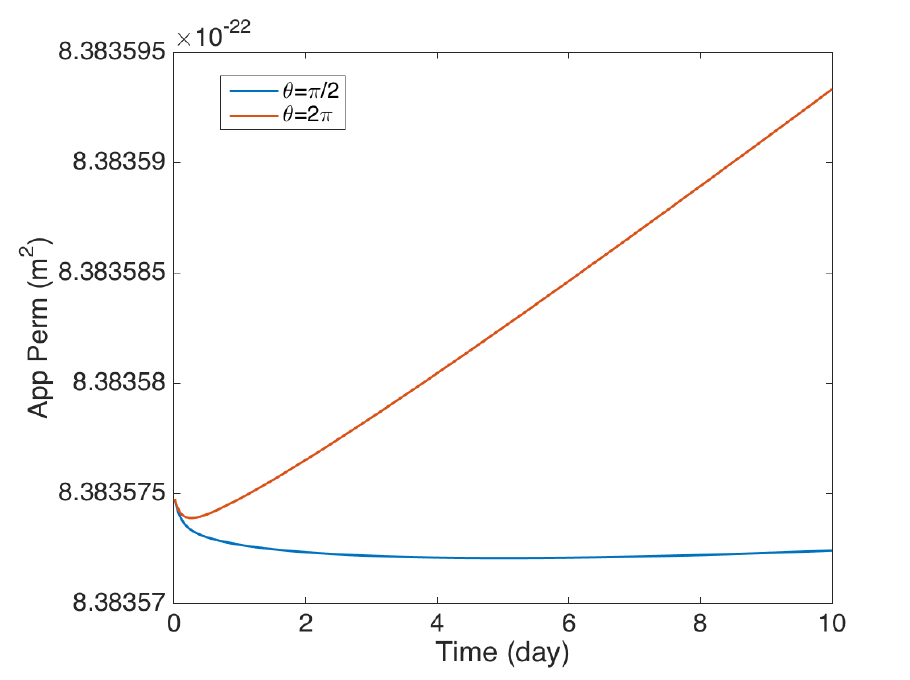
Figure 14. The average apparent permeability for various values of the parameter θ